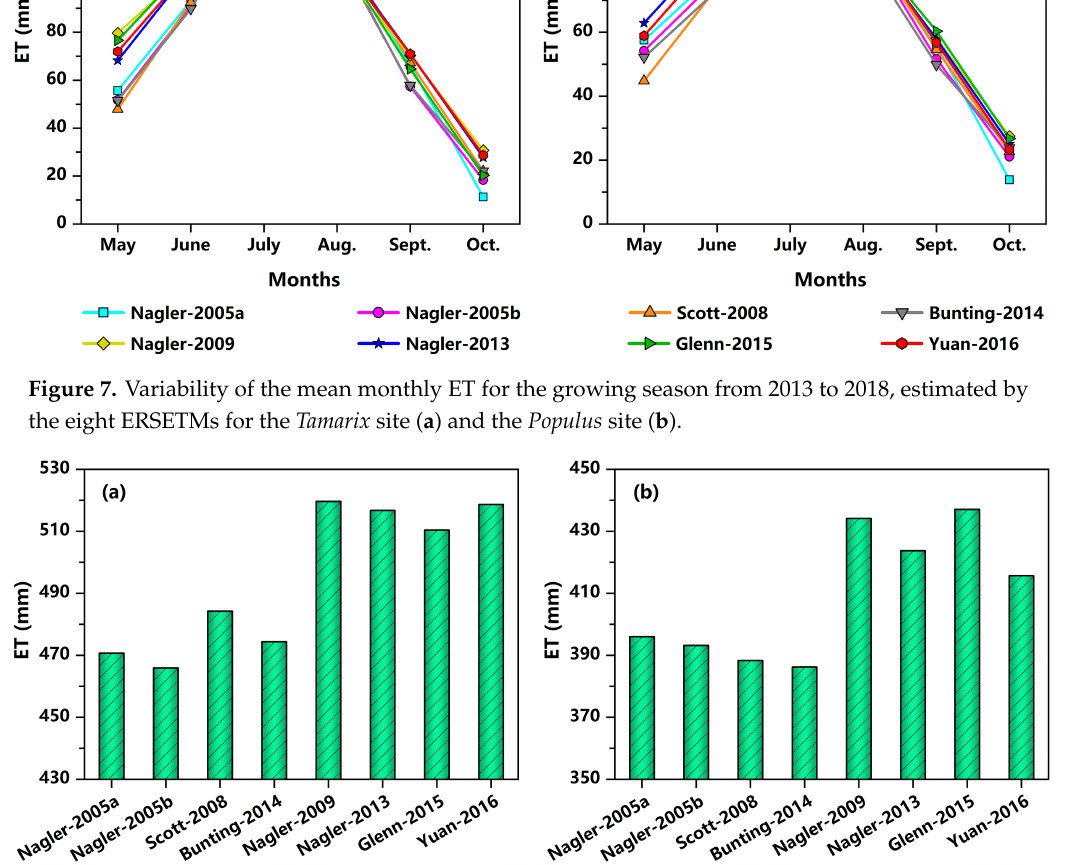
Figure 8. Mean ET of the growing season from 2013 to 2018, estimated by the eight ERSETMs for the Tamarix site ( a ) and the Populus site ( b ).